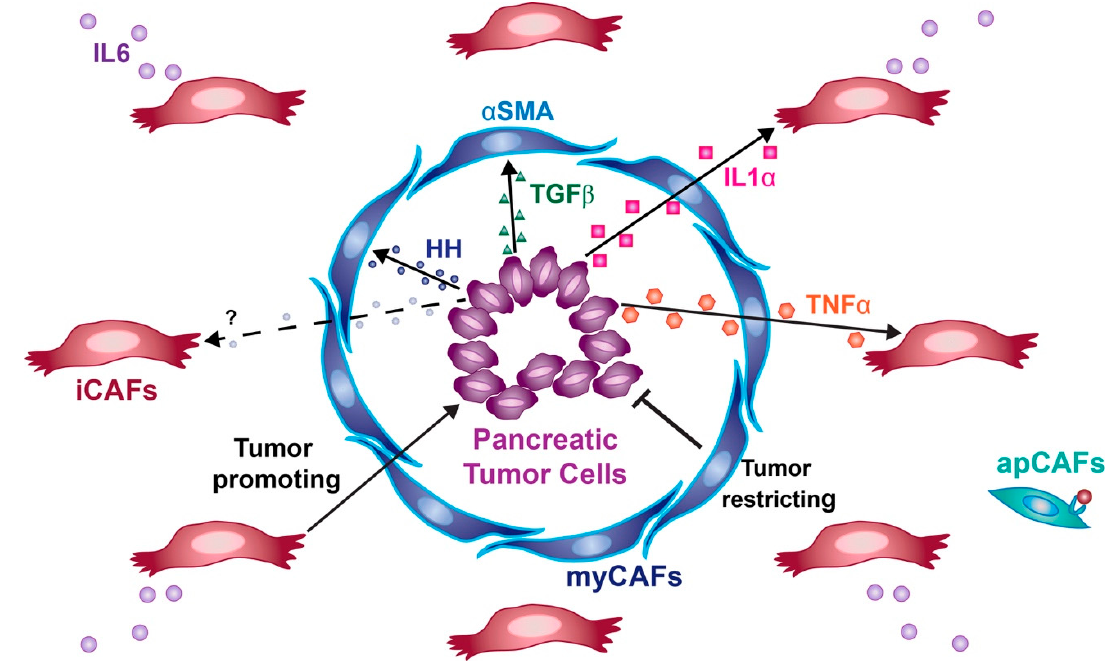
Figure 1. Key stromal signals in PDA. myCAFs (blue) respond to HH and TGF- β ligands secreted by tumor cells (purple), express high levels of α SMA, and restrict tumor growth. iCAFs (red) are maintained by tumor-derived IL1 α and TNF α , express IL6, and promote tumor growth. apCAFs (teal) express MHC Class II and can present antigens to T cells.